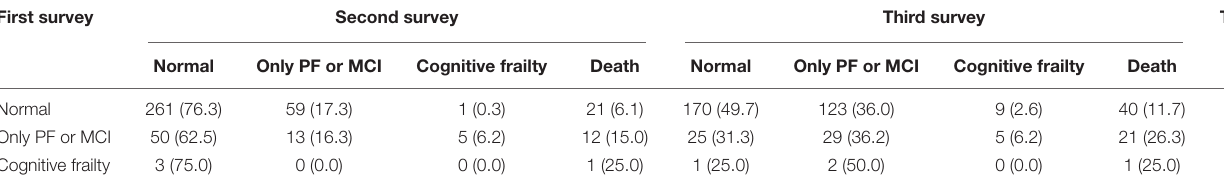
TABLE 4 | Transitions in cognitive frailty states in community-living older adults in three visits 6 years apart. First survey